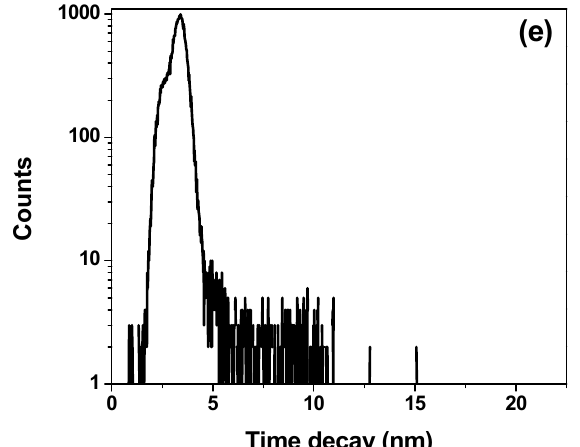
Figure 8 . Lifetime decays of PFO/10 wt% MEH ‐ PPV with various ratios of STNCs ( a ) 0, ( b ) 5 wt%, ( c ) 10 wt%, ( d ) 15 wt% & ( e ) 20 wt% at emission wavelength of 440 nm. λ ex = 376.4 nm.